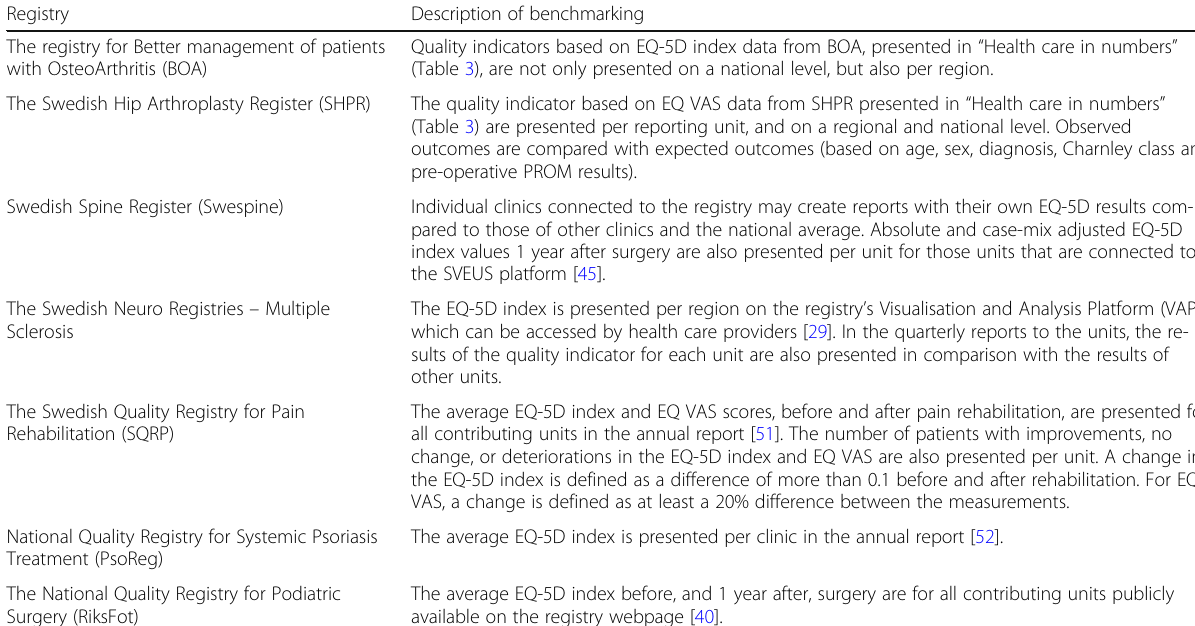
Table 4 Use of EQ-5D data for benchmarking Registry Description of